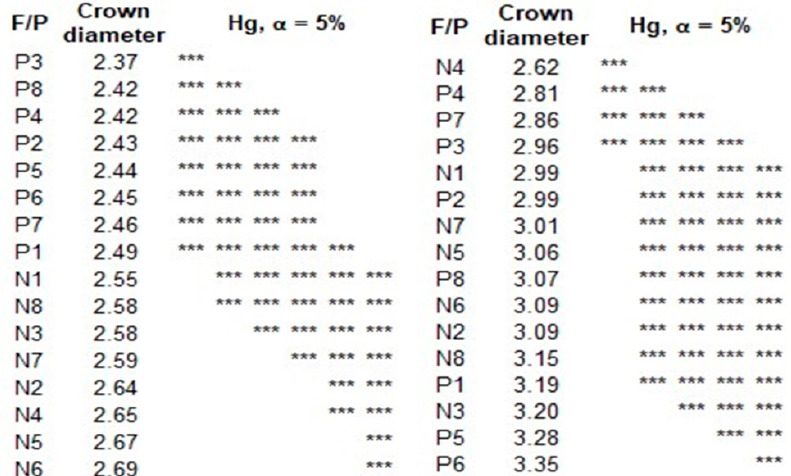
Figure 3. Duncan’s test for crown diameter in the M ă neciu ( left ) and Soveja ( right ) trials. Homogeneous groups (Hg) for α = 5%.